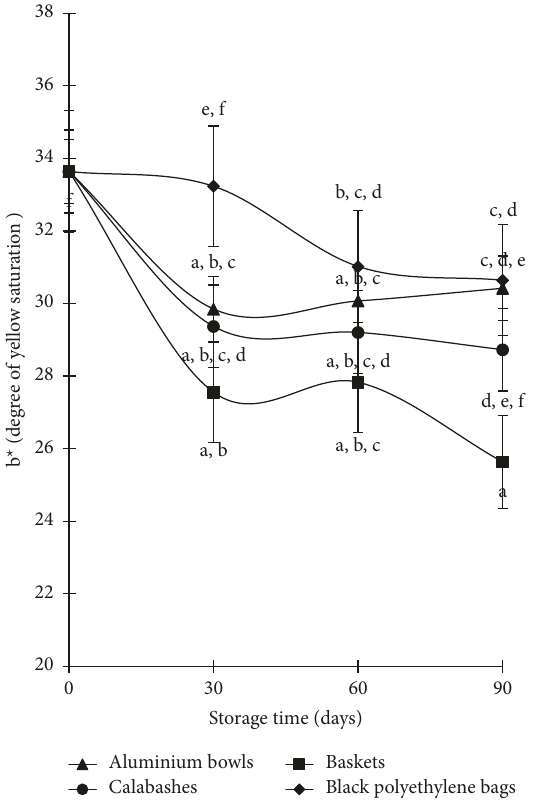
Figure 5: Effect of packaging on the yellow saturation index of butter during storage ( n �